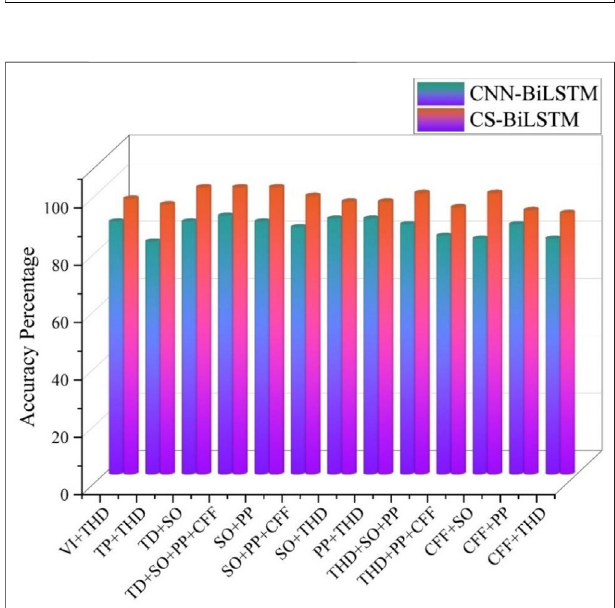
FIGURE 12 | Classi fi cation results of power quality disturbance signals with 20 dB compression